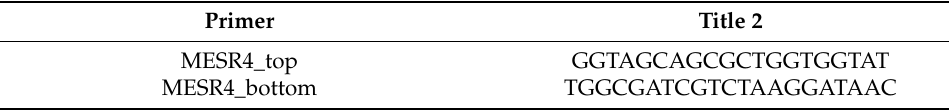
Table 1. List of sgRNAs used for MESR4 mutant generation.